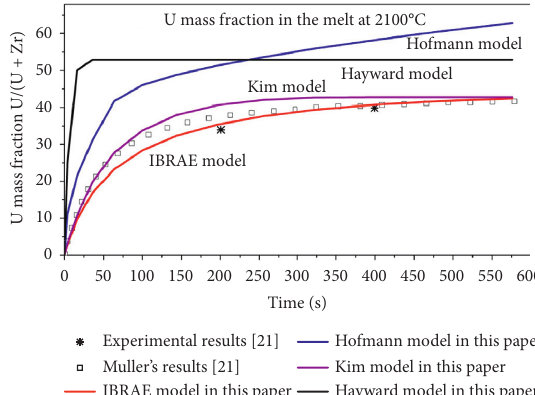
Figure 6: Comparison of fractional oxide layer thickness in cladding.